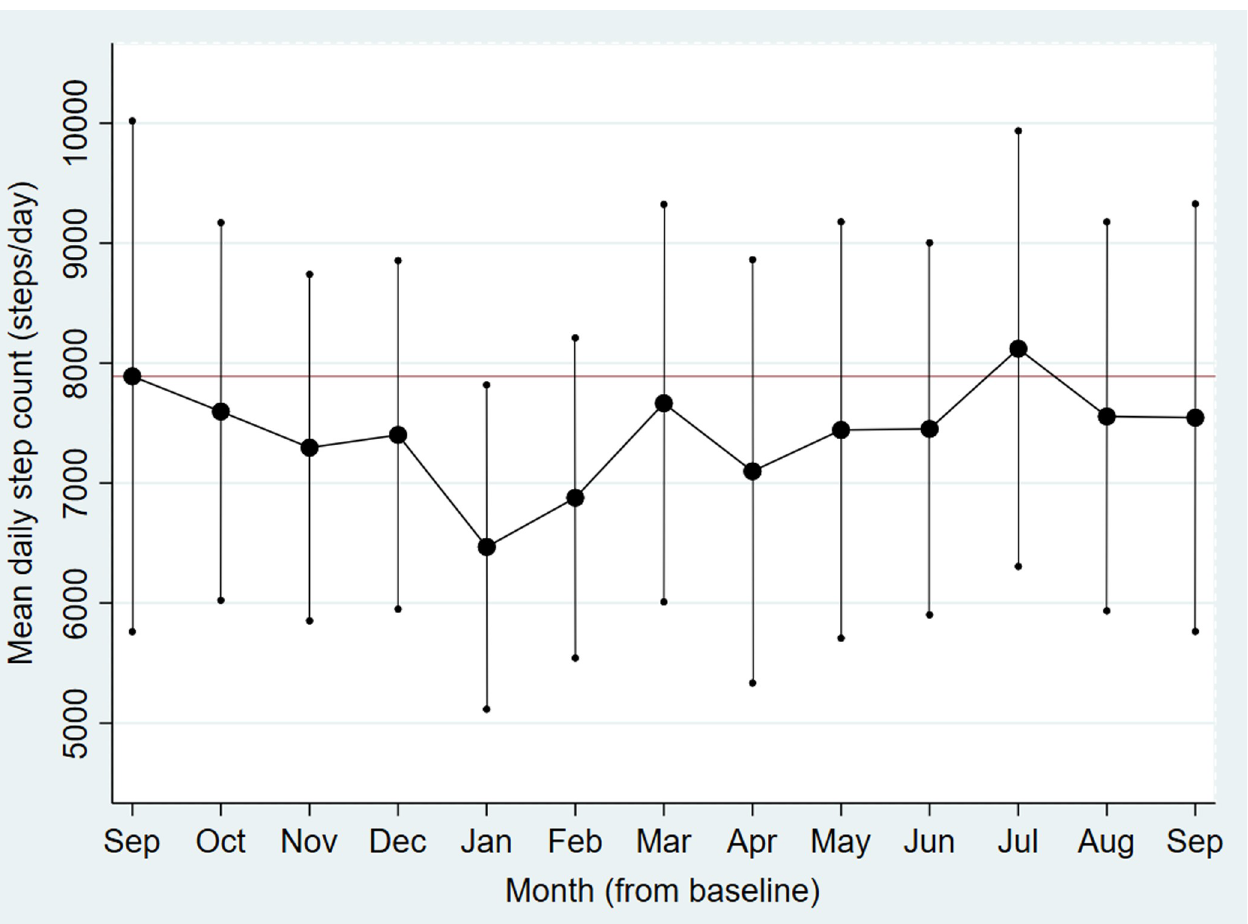
Fig 2. Monthly mean daily step count from baseline to end-of-follow-up. The RESTART pilot study 2017–18. Dots are monthly mean number of steps per day, vertical lines are corresponding confi- dence intervals. The horizontal line represents the baseline mean. Dots are monthly mean minutes (min) of moderate-to-vigorous physical activity (MVPA) per day, vertical lines are corresponding confidence intervals. The horizontal line represents the baseline mean. Dots are monthly mean total energy expenditure in kilocalories (kcal) per day vertical lines are corresponding confidence intervals. The horizontal line represents the baseline mean.